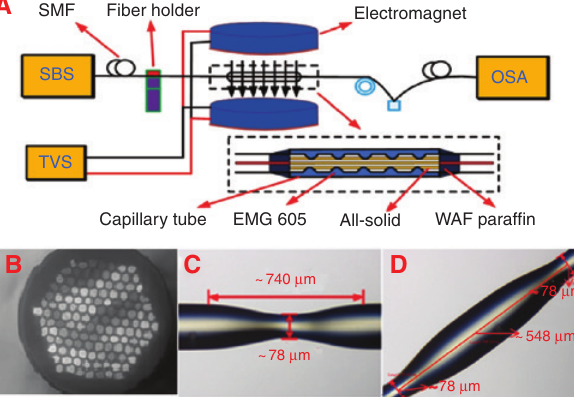
Figure 1: (A) Schematic diagram of the experimental setup for magnetic field tunability experiment. (B) Cross-sectional image of the all-solid WAF. (C) Microscopic image of a typical taper fabricated in the all-solid WAF. (D) Microscopic image of the spacing between two adjacent